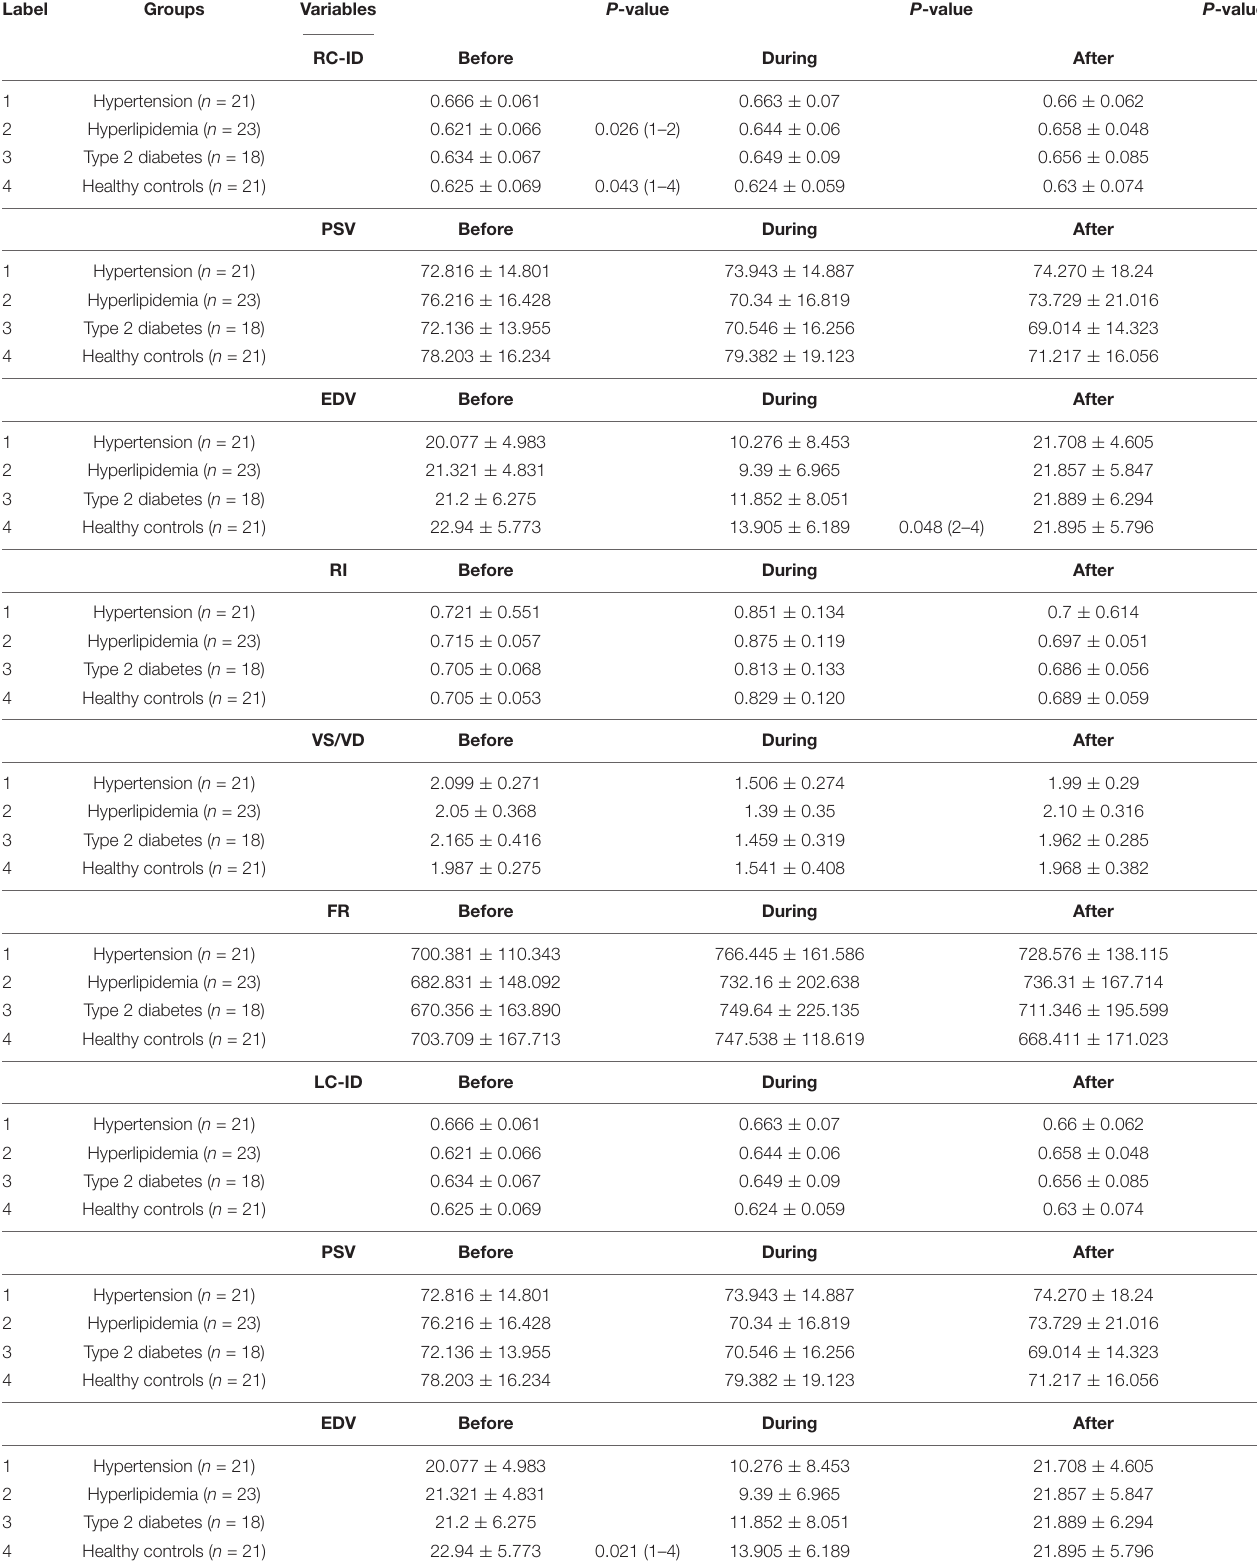
TABLE 3 | Differences of Hemodynamic variables in the common carotid artery among four groups before, during and immediately after 45